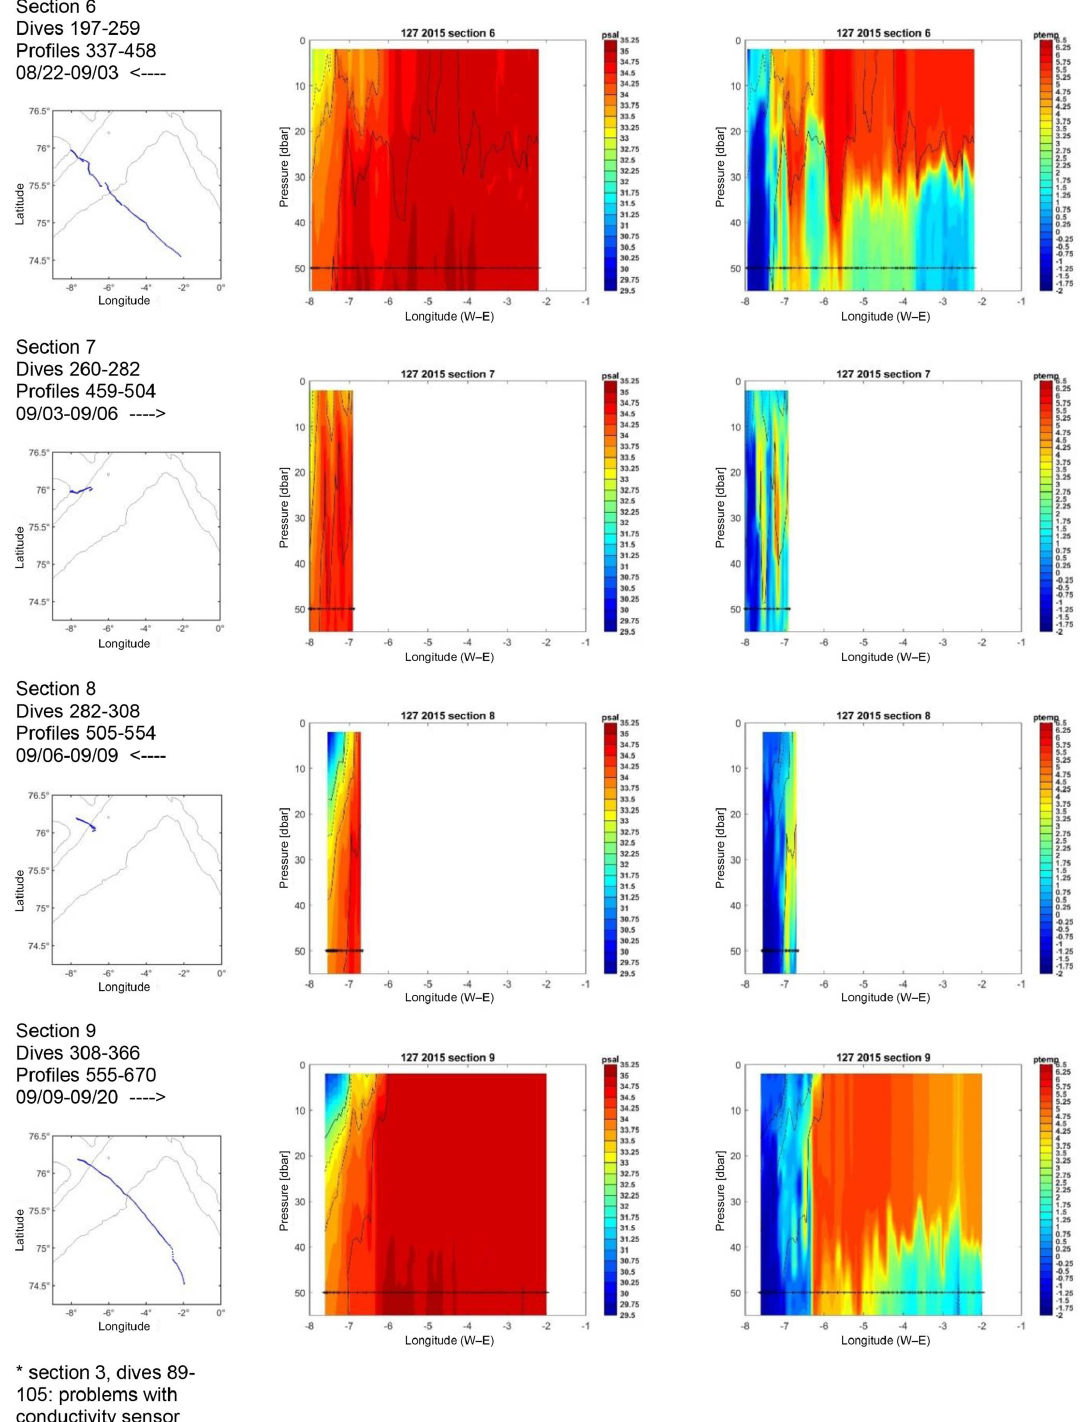
Figure 10. Sections: 2015, glider 127, sections 1–9. Shown is the upper 55m of the water column. Left column: information and map extract with location of the profiles (no ice was observed during the whole mission time in the map extract); number of original dives in the section, number of profiles from the final data set in the section, time span, and direction of the section: < --- east to west, --- > west to east. Middle/right column: salinity/potential temperature. Both plots are overlaid with the sigma-contours 26.0, 26.5, 27.0, 27.5 and 28.0kgm − 3 (see legend for line style in Fig. 7). Stars at 50m depth mark the position of the profiles on the section before the gridding of the data in the horizontal took place. For section 3 many profiles are missing because of problems with the conductivity